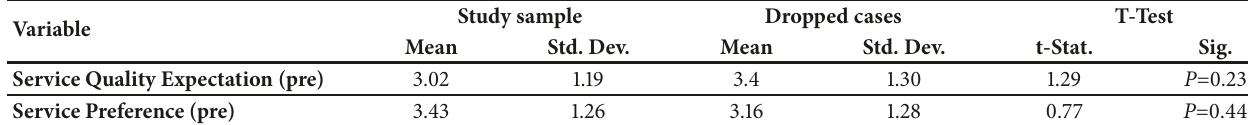
Table 3: Post hoc assessment of self-selection